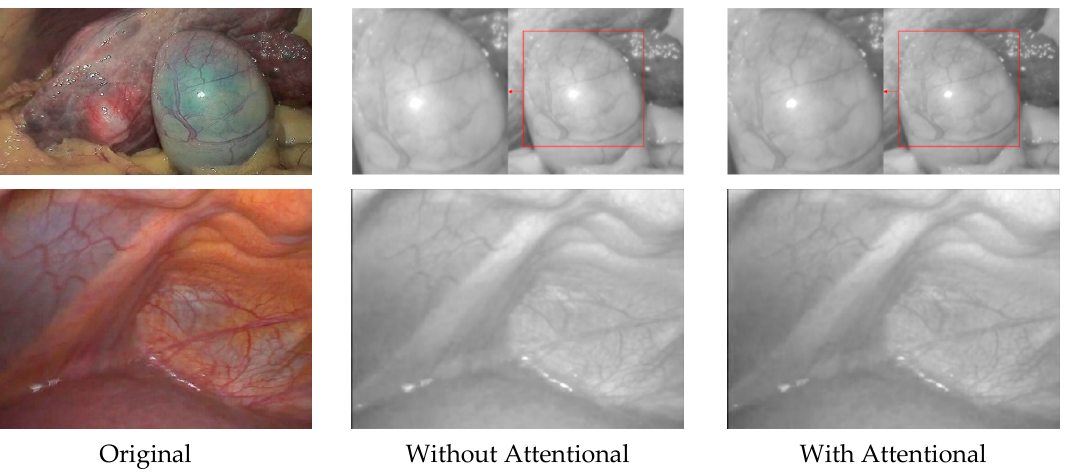
Figure 12. Results of comparison with and without attention mechanism. Locally over-enhanced regions are shown in the red square.